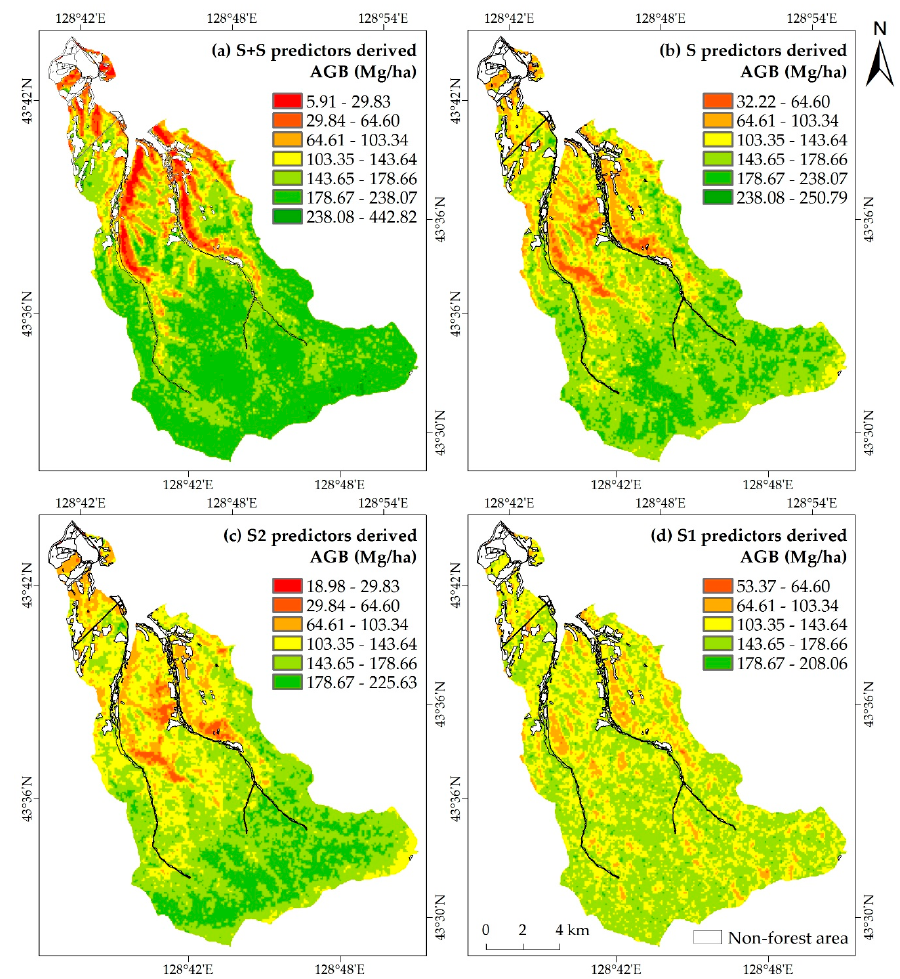
Figure 6. Maps of AGB prediction in the study area derived from the best combination of predictors and models, based on the Sentinel series and the SRTM DEM data: ( a ) S+S with RF; ( b ) S with RF; ( c ) S2 with RF; ( d ) S1 with RF. ( c ) S2 with RF; ( d ) S1 with